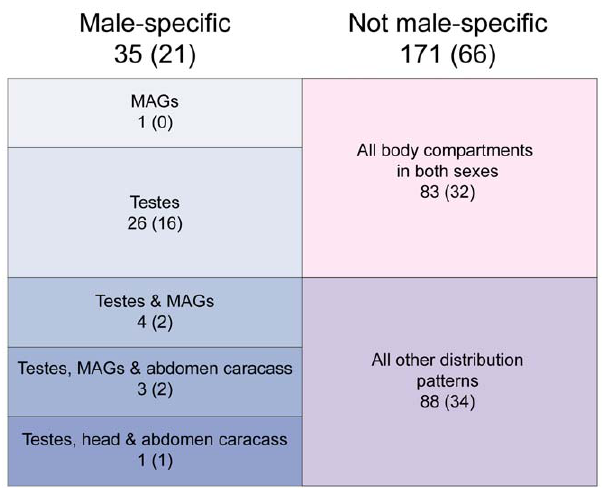
Figure 4. Tissue distribution of 206 transcripts that putatively encode secreted peptides as determined by RT-PCR on male and female body compartments. Figures in brackets indicate the number of transcripts that shared no significant similarity to known proteins.